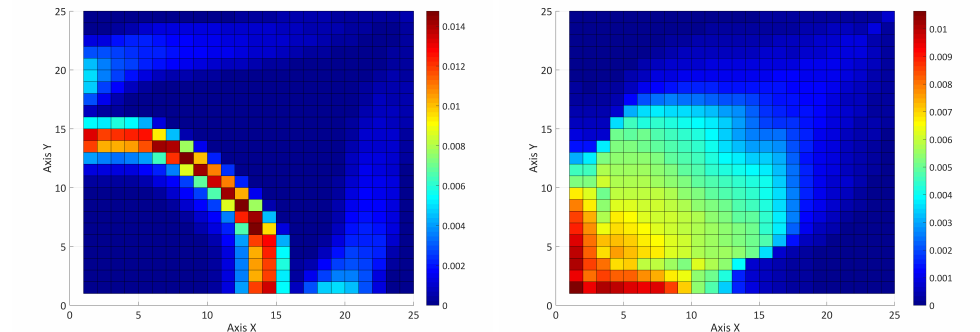
Figure 9. Combined chemical agents slugs in a P+S flooding scheme after 1000 days (separated– left ) and amount of surfactant adsorbed after 3000 days (overlapped– right